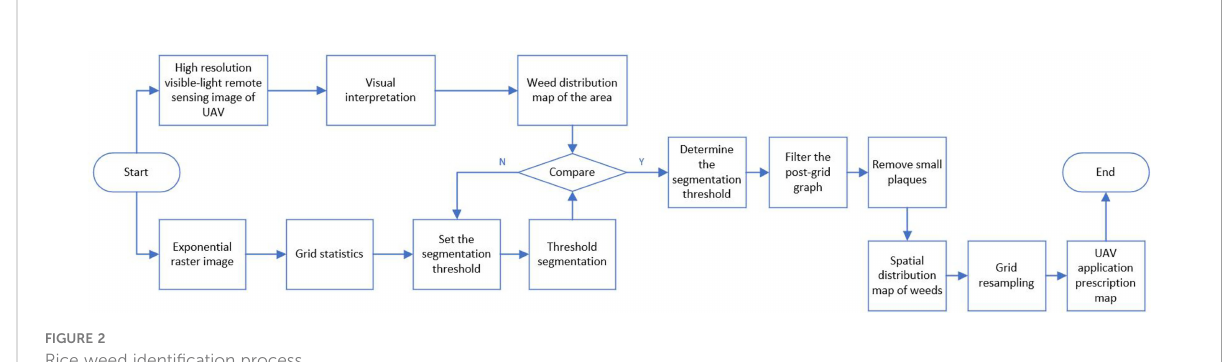
FIGURE 2 Rice weed identi fi cation process.